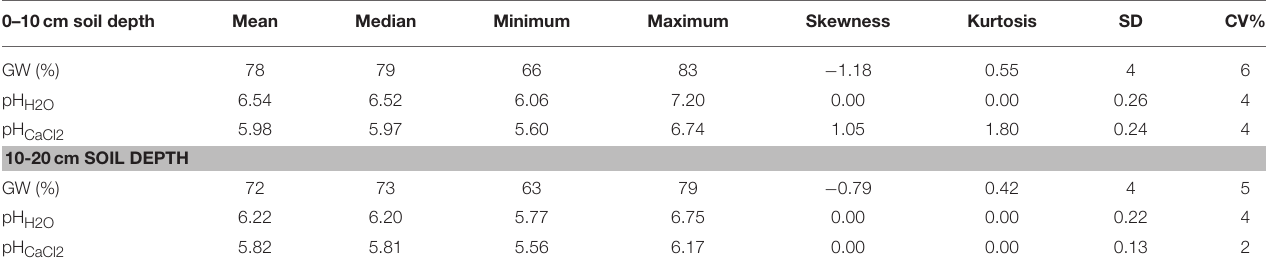
TABLE 1 | Gravimetric water (GW) content and pH in the surface and subsurface soil of a rewetted peatland. 0–10cm soil depth